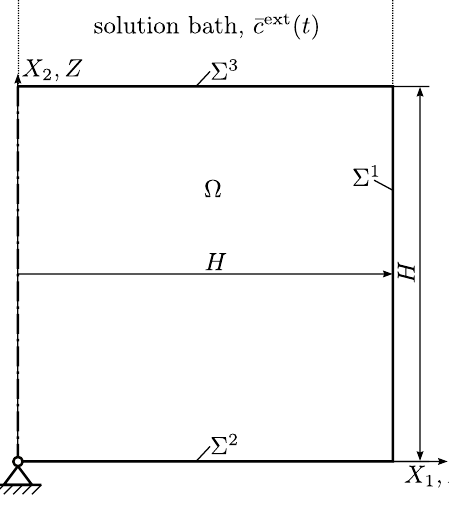
Figure 5. Illustration of example problem